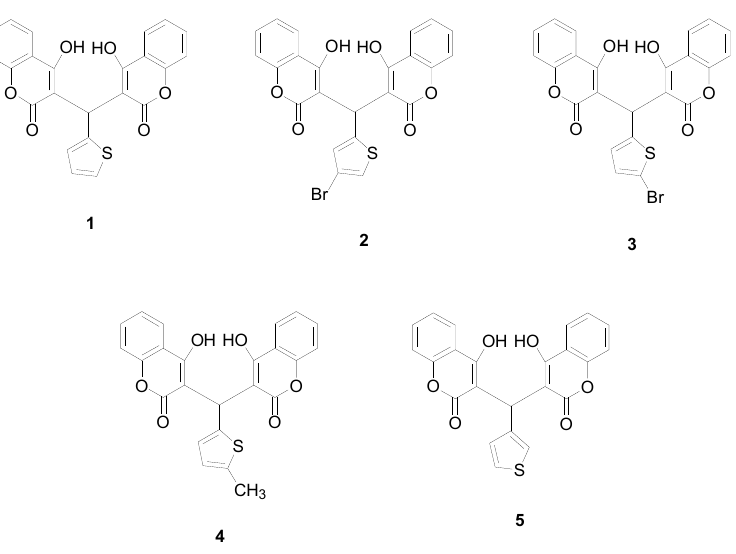
Figure 1. Chemical structures of compounds 1 – 5